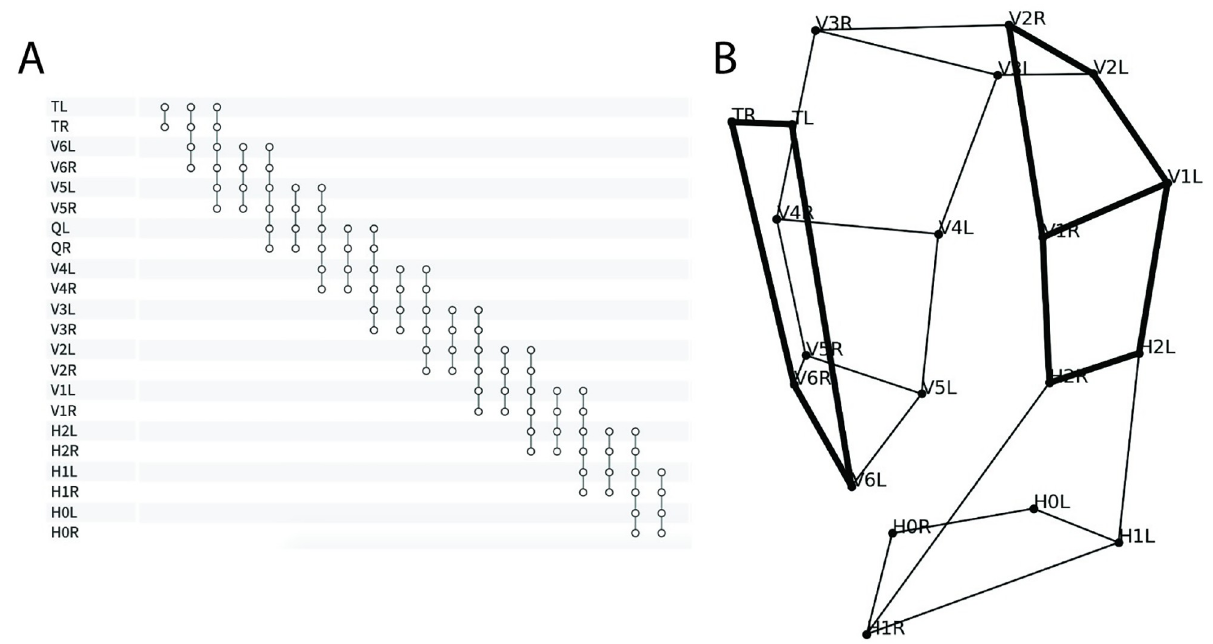
Fig 7. The Pairs hypergraphical model uses expansive local contexts about each portion of the embryo. A: The Pairs hyperedges connect local seam cell nuclei in sets of four and six. B: Degree four hyperedges connect sequential pairs of seam cells while degree six hyperedges connect sequential triplets of pairs. The posterior-most degree four hyperedge and a central degree six hyperedge are bolded .